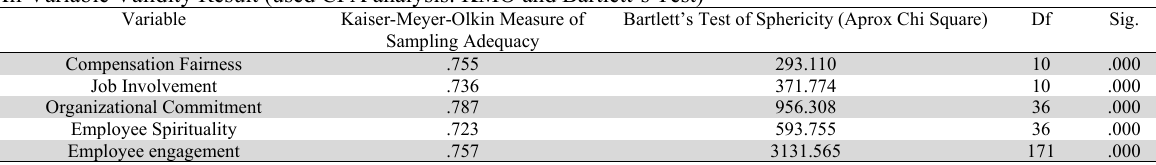
All Variable Validity Result (used CFA analysis: KMO and Bartlett’s Test)